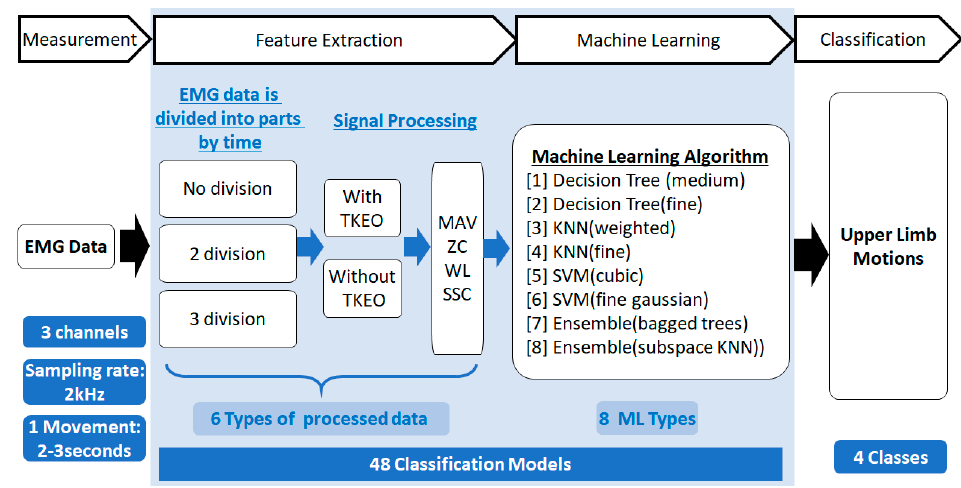
Figure 2. Classification models for comparative evaluation.